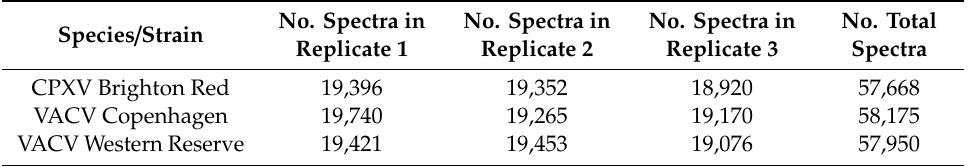
Table 2. This table shows the number of spectra from each sample replicate for CPXV Brighton Red, VACV Copenhagen, and VACV Western Reserve virus species /